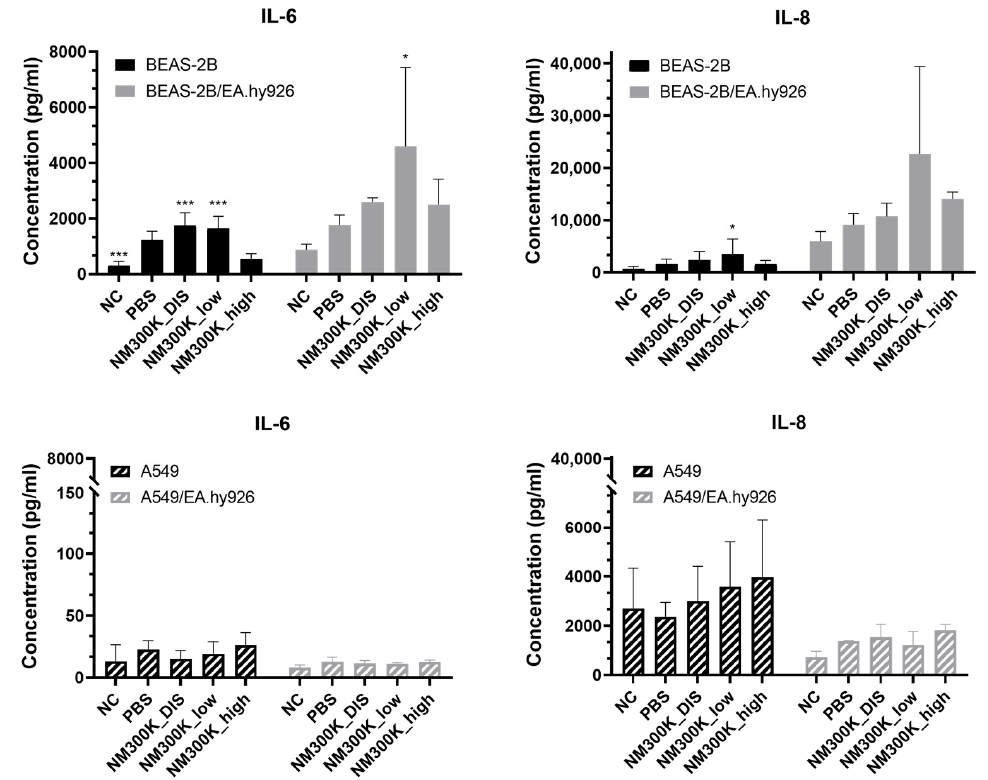
Figure 4. Concentrations of IL-6 and IL-8 in mono- and cocultures of BEAS-2B/EA.hy926 cells (top panel) and A549/EA.hy926 cells (bottom panel) after exposure to aerosolized NM-300K and control solutions at the air–liquid interface, evaluated by ELISA. Results are presented as the mean with standard deviation from single or duplicate inserts from n = 2–6 independent experiments ( n = 6 for BEAS-2B monocultures, n = 3 for BEAS-2B/EA.hy926 cocultures and A549 monocultures, and n = 2 for A549/EA.hy926 cocultures). Statistically significant different effects on cytokine concentration compared to the negative control inserts with PBS-exposed cells (PBS) were analyzed by one-way ANOVA followed by Dunnett ´ s post-hoc test (* p < 0.05, *** p < 0.001). NC: negative control, PBS: phosphate-buffered saline, NM-300K DIS: dispersant control, NM-300K low: nominal 1 µ g/cm 2 , NM-300K high: nominal 10 µ g/cm 2